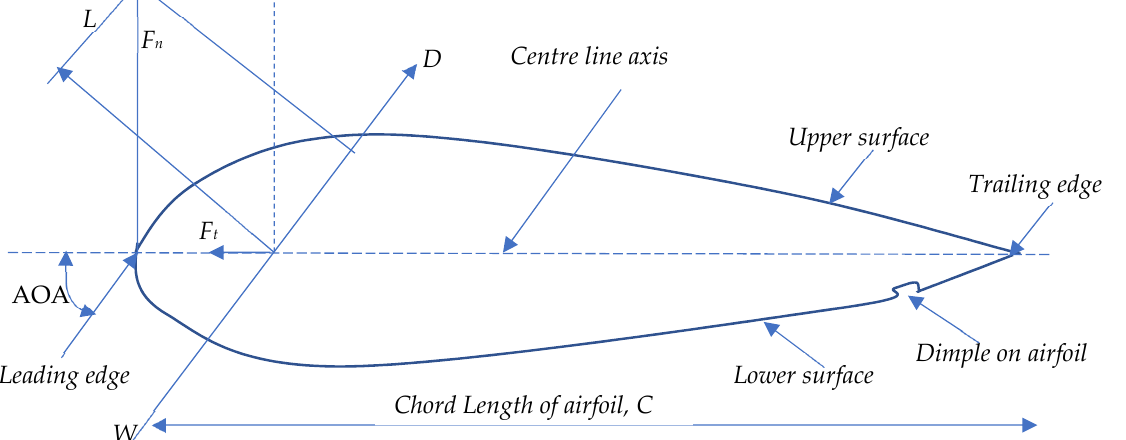
Figure 1 . Illustration depicting the constituent forces acting on dimpled aerofoils, including its AOA.